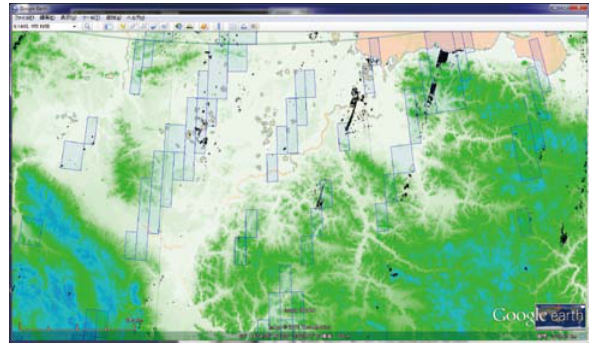
Figure 6. Example of GDEM version 2 image (north-eastern Russia) with the AOIs (blue rectangles) in GDEM-3